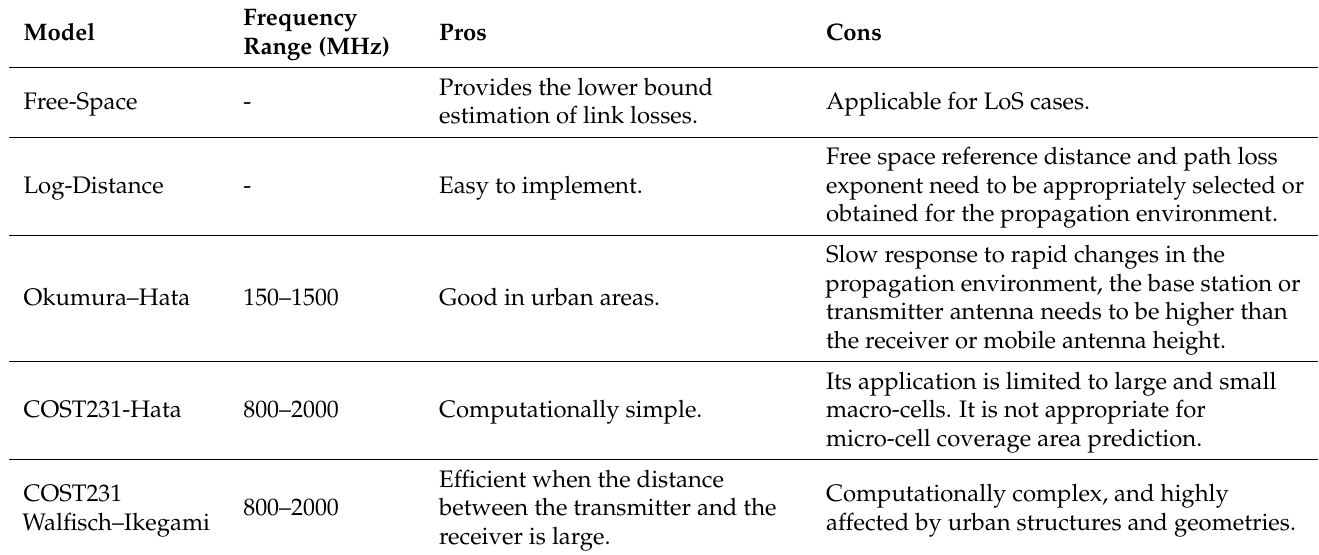
Table 1. Comparison between the empirical path loss models for outdoor